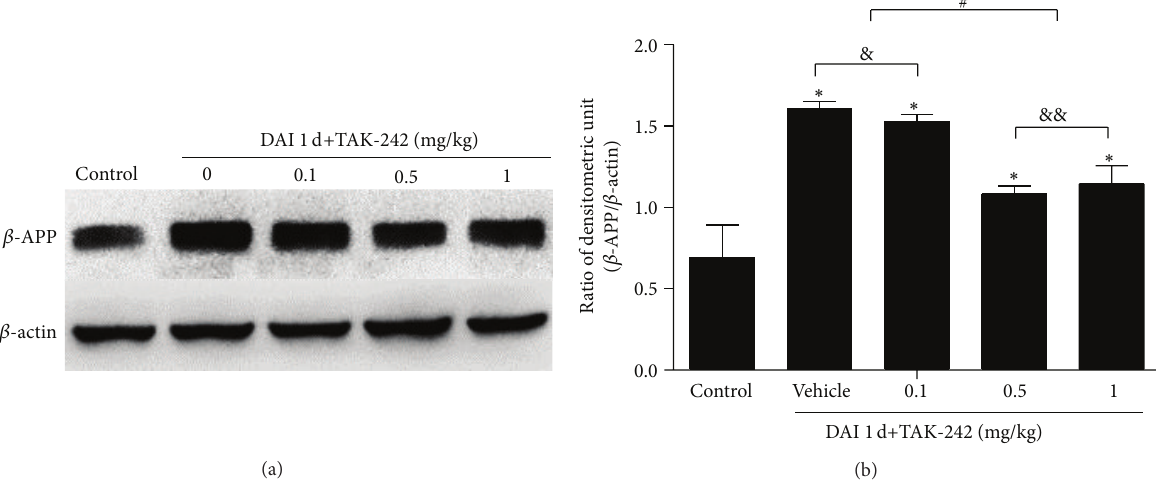
Figure 4: Determination of the optimal dose of TAK-242. (a) The effects of different doses of TAK-242 (0.1, 0.5, or 1mg/kg) on DAI were determined via western blotting and measurement of 𝛽 -APP expression. (b) The bar graphs show the 𝛽 -APP expression results in the cortex after administration of different doses of TAK-242. The expression of 𝛽 -actin was used as an internal control. Values are presented as the mean ± SD ( 𝑛 = 6 ; ∗ 𝑝 < 0.05 , compared with control group; & 𝑝 > 0.05 , compared with DAI 1d+vehicle group; && 𝑝 > 0.05 , # 𝑝 < 0.05 , compared with DAI 1 d+TAK-242 (0.5mg/kg)